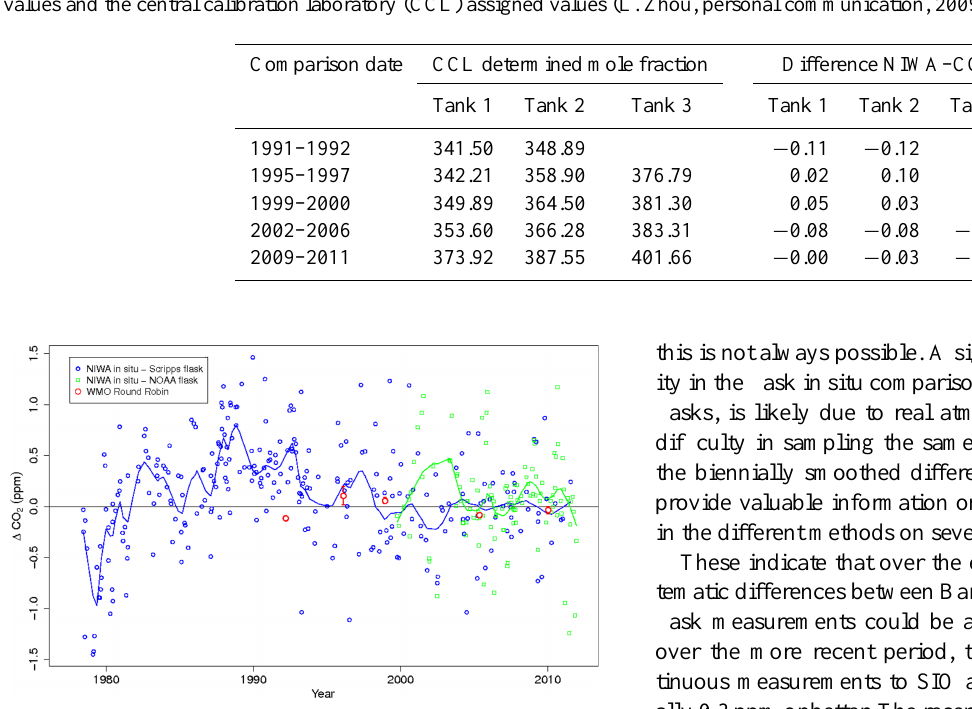
Table 1. Results from WMO round robin tank intercomparisons, tabulated as the ppm differences between the DSIR/NIWA determined values and the central calibration laboratory (CCL) assigned values (L. Zhou, personal communication, 2009–2011).